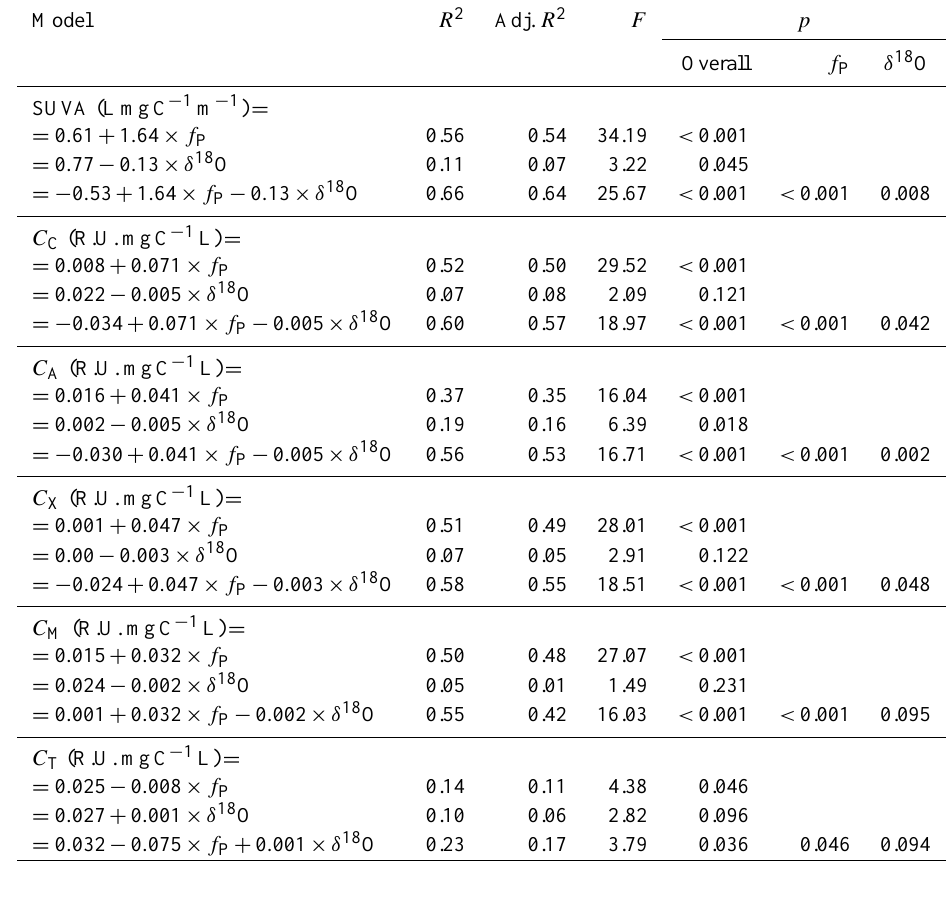
Table 4. Regression analysis where lake DOC composition indices (SUVA along with the five PARAFAC components) are dependent variables, while f P (indicating relative contribution from peatland and mineral DOC sources to lakes) and δ 18 O (indicating lake water residence time) are continuous independent variables.